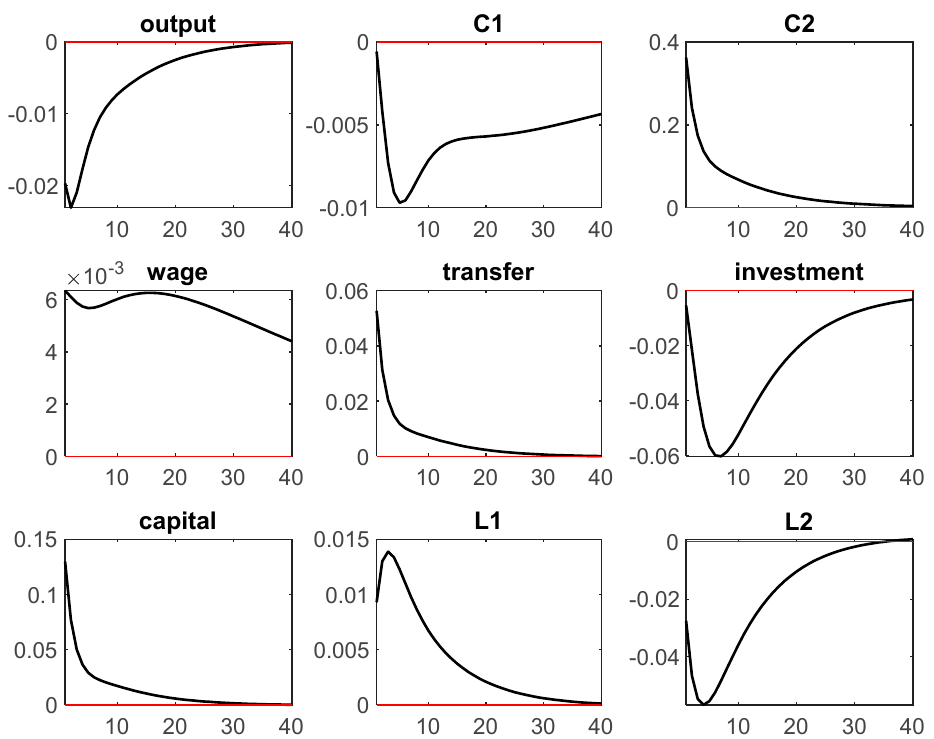
Figure 3. The effects of fiscal policy (capital tax rate reduction and fiscal deficit increase) on key Korean macroeconomic variables.